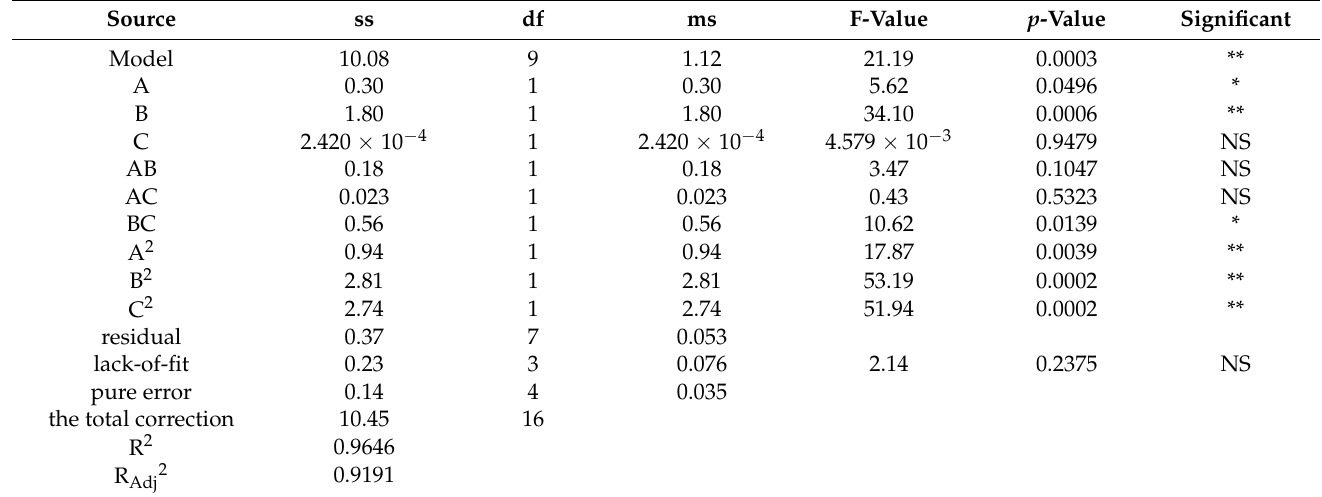
Table 3. ANOVA for response surface model